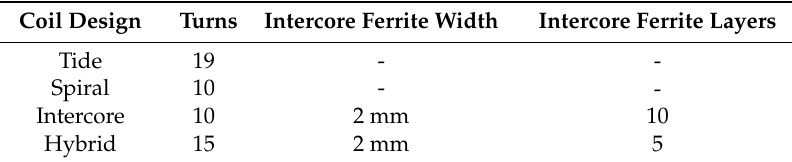
Table 2. Model-specific